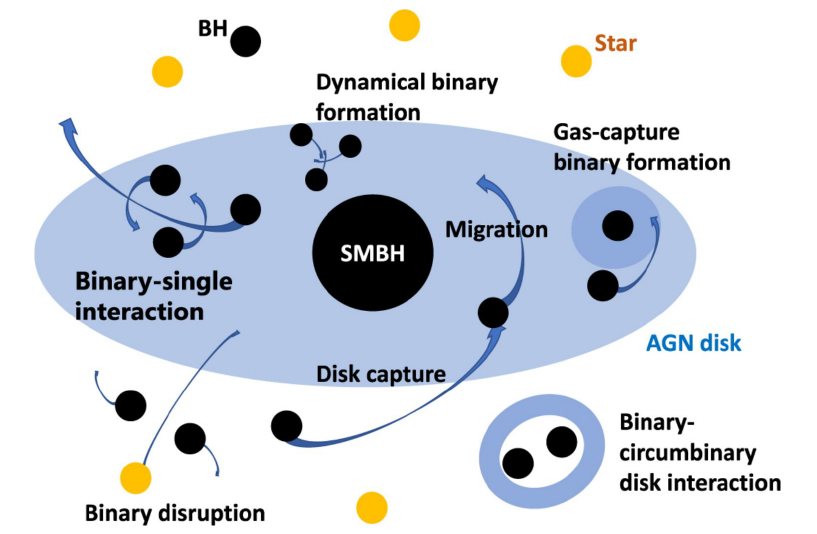
Figure 13. Schematic illustration of the different processes that contribute to black hole binary formation in the disc of an active galactic nucleus. Taken from Tagawa et al, ApJ, 2020, 898(1), 25 ©AAS. [33]. Reproduced with